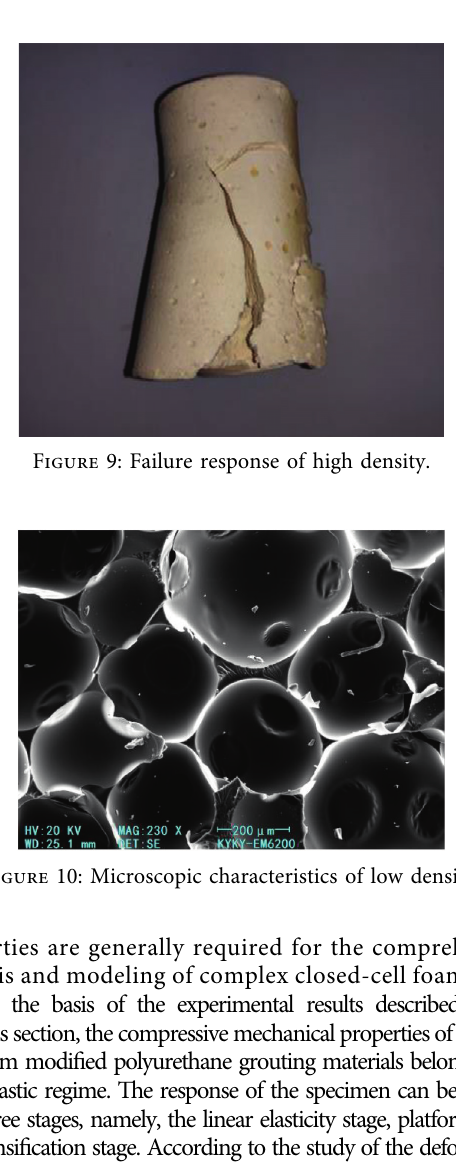
Figure 8: Failure response of low density.